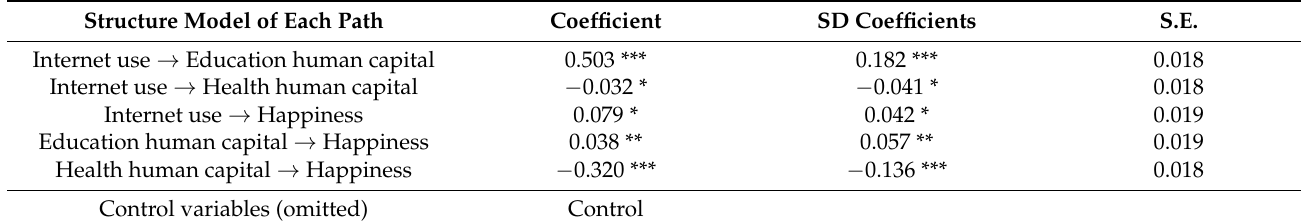
Table 3. Analysis of the mediating effects of household human capital.